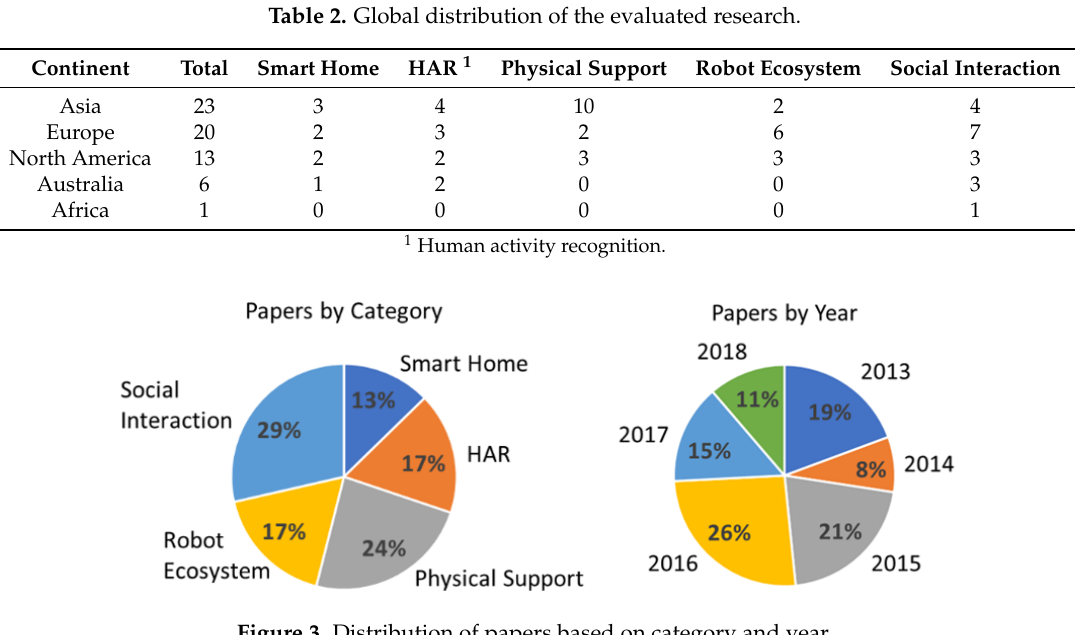
Figure 3. Distribution of papers based on category and